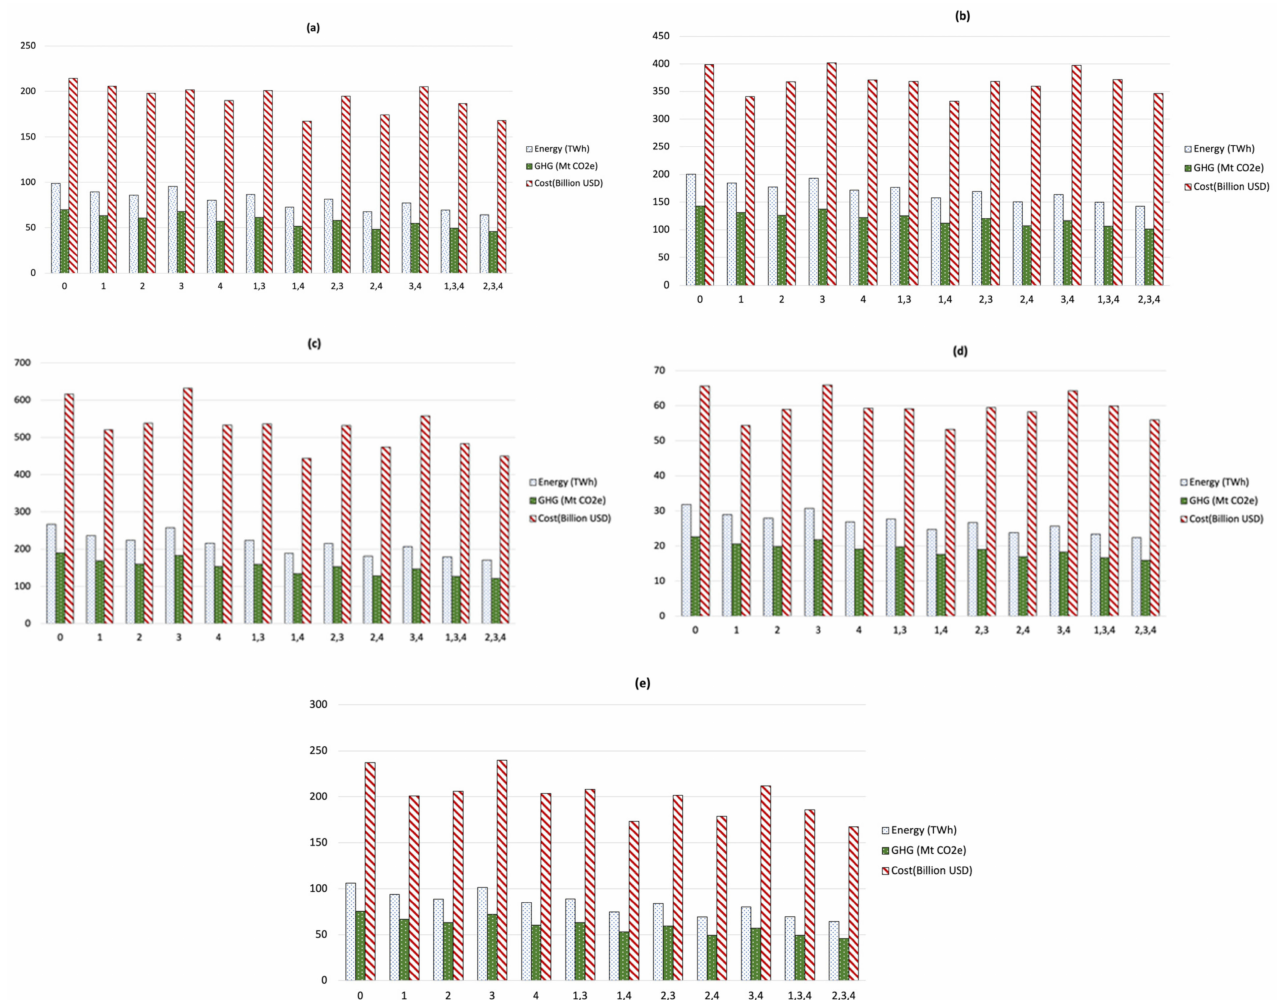
Figure 6. Energy-GHG-Cost in ( a ) southern ( b ) western ( c ) central ( d ) northern ( e ) eastern regions of Saudi